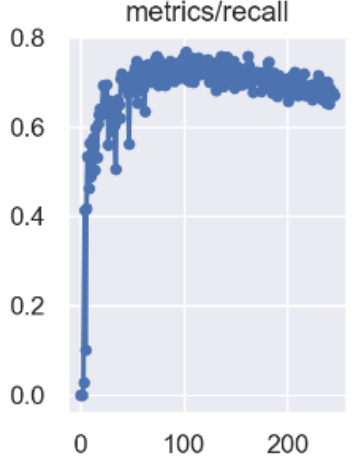
Figure A10. The changes of recall of YOLOV5l.